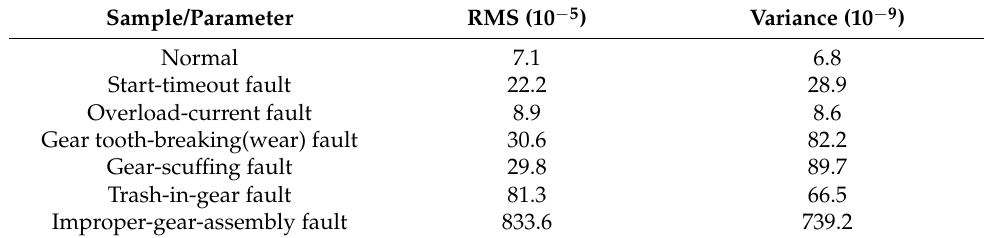
Figure 9. Signal of improper-gear-assembly fault. Table 2. Statistical results of time-domain parameters.